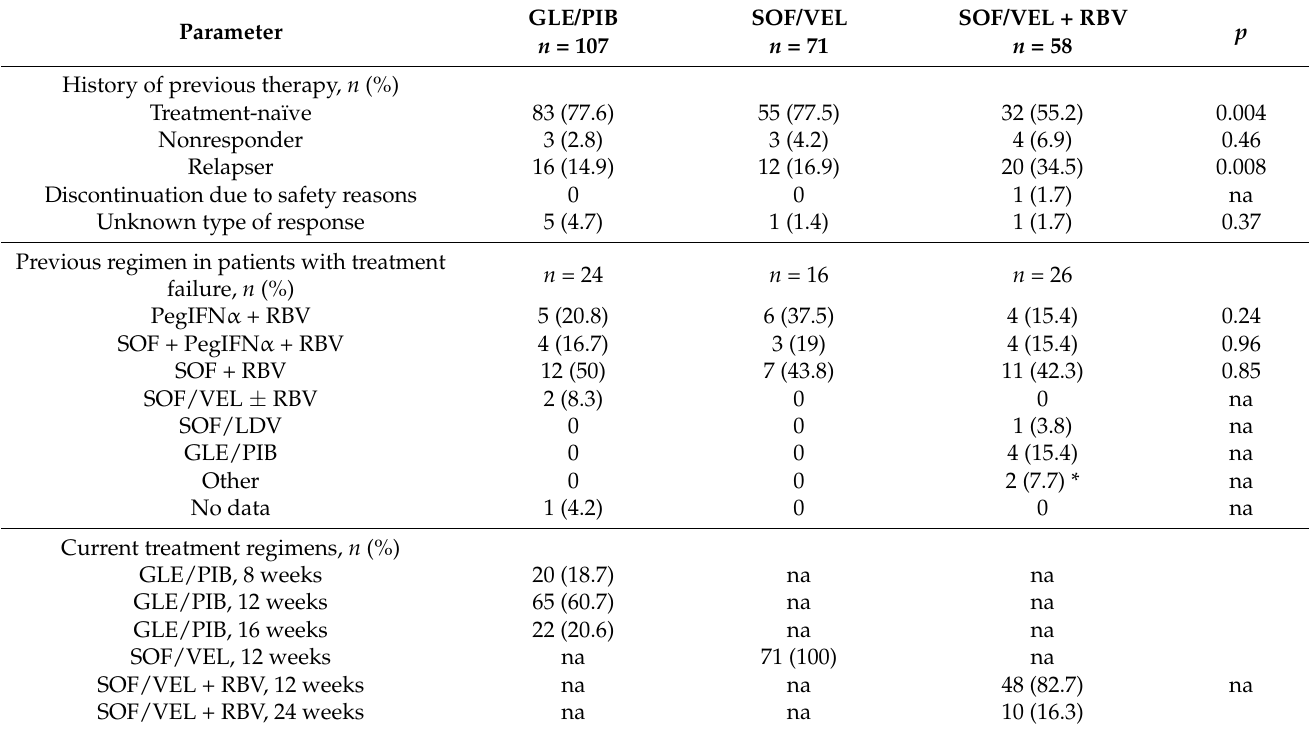
Table 3. Previous and current treatment characteristics of GT3 HCV infected patients with liver cirrhosis treated with pangenotypic regimens.